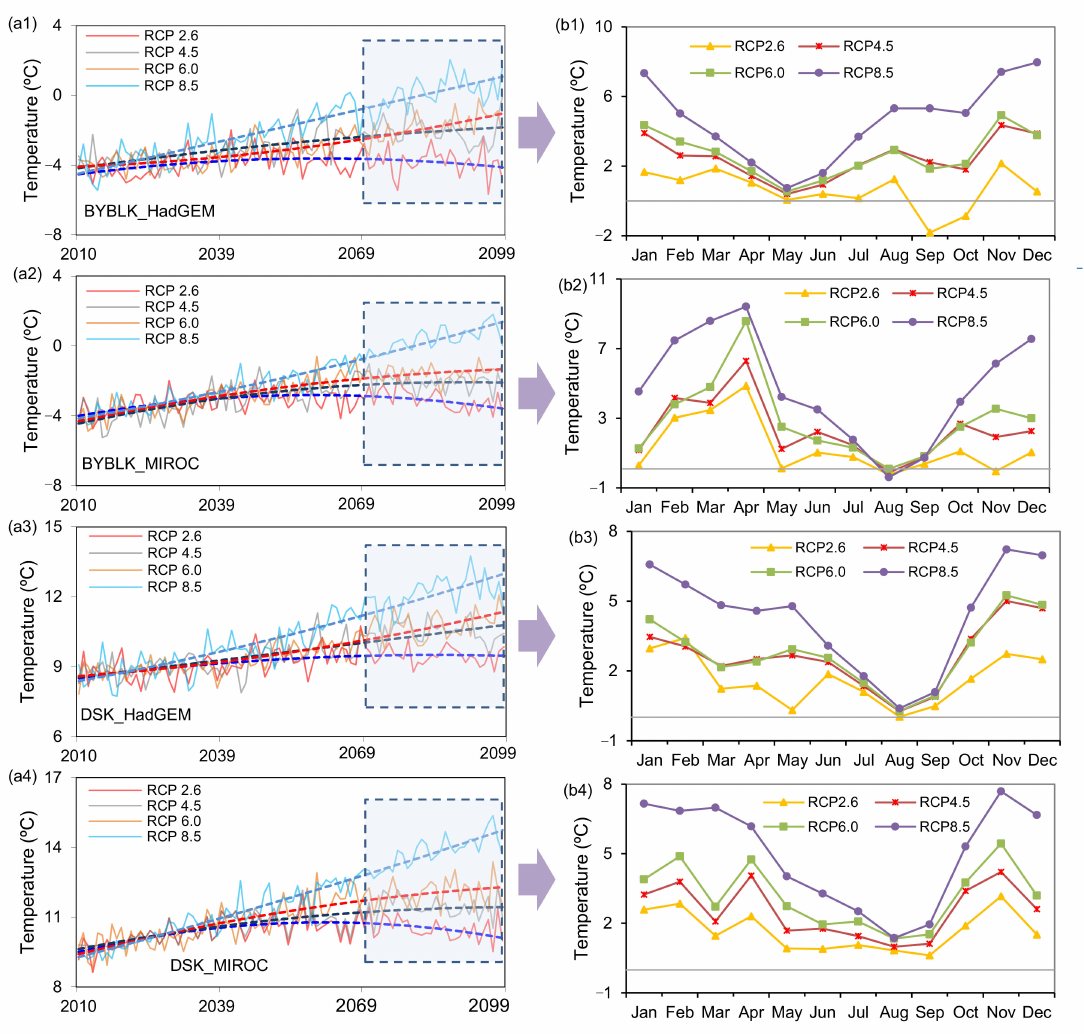
Figure 3. Temperature under di ff erent scenarios [( a1 )–( a4 ) are the annual temperature during the period 2010–2099 and ( b1 )–( b4 ) are the monthly average changes in 2080s compared with baseline